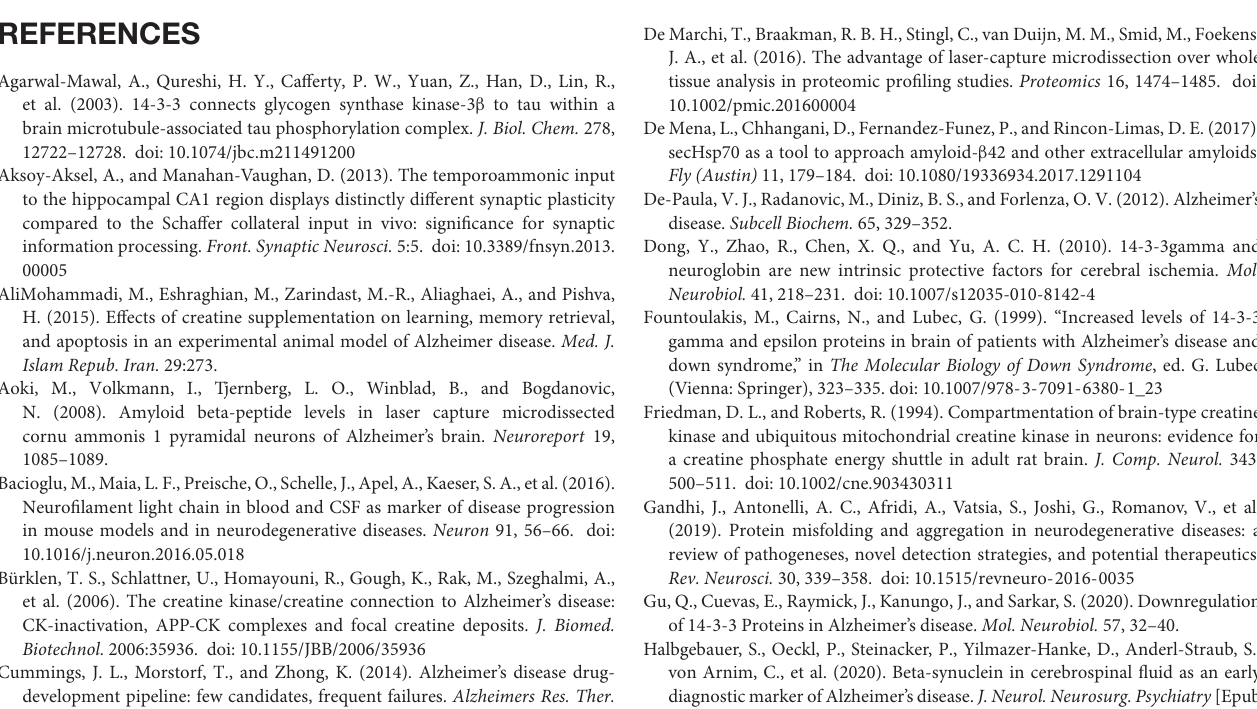
Supplementary Figure 1 | Negative controls from the respective experiments when analyzing CKB, 14-3-3- γ and Hsc71 by immunohistochemistry. CKB, Creatine kinase B; Hsc71, heat shock cognate. Supplementary Table 1 | In total, 470 proteins were identified from the proteomic analysis of the LCM extracted CA1 neurons (10 cases). Most of the proteins were identified in less than two cases from each group (AD and control). Proteins are sorted based on the difference between AD and controls. LCM, laser capture microdissection ; CA1, cornu ammonis 1; AD: Alzheimer’s disease. Supplementary Table 2 | Individual lists of the proteins identified from the mass spectrometric analysis including the number of peptides identified for each case (1–5). C: control; AD: Alzheimer’s